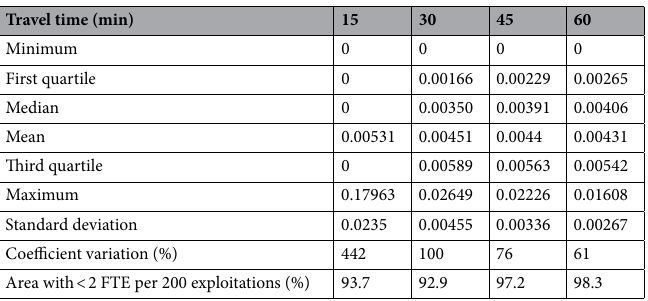
Table 3. 2SFCA accessibility index distribution based on 4 travel time